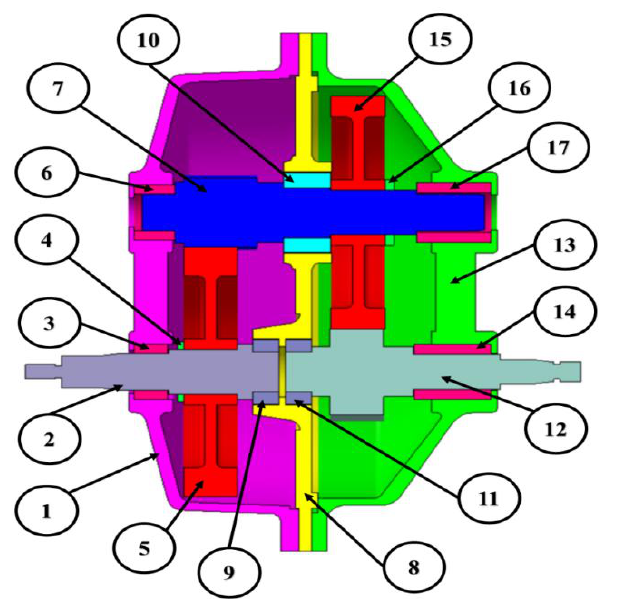
Figure 1. 17-part reduction gear box assembly cut section